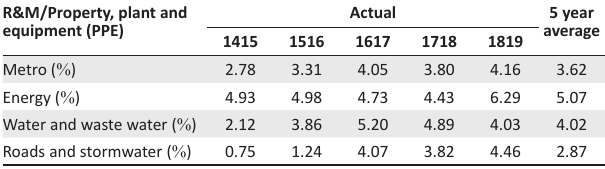
TABLE 2: Averages of renewals over total property, plant and equipment.